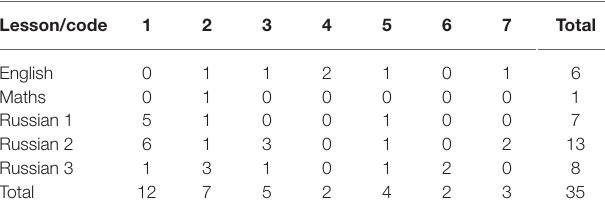
TABLE 5 | Number of classroom events (C1-C7) according to the lesson (J2).